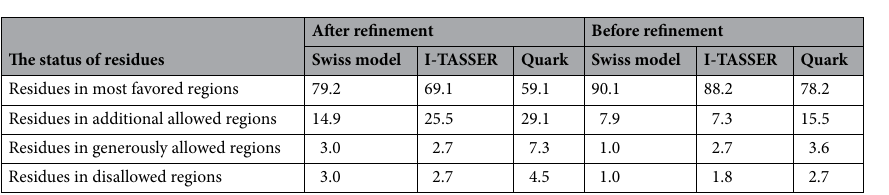
Table 3. The Ramachandran analysis for predicted Pseudomonas aeruginosa LptA tertiary structures, before and after refinement, by three different procedures; Homology modeling, Threading, De novo (%).